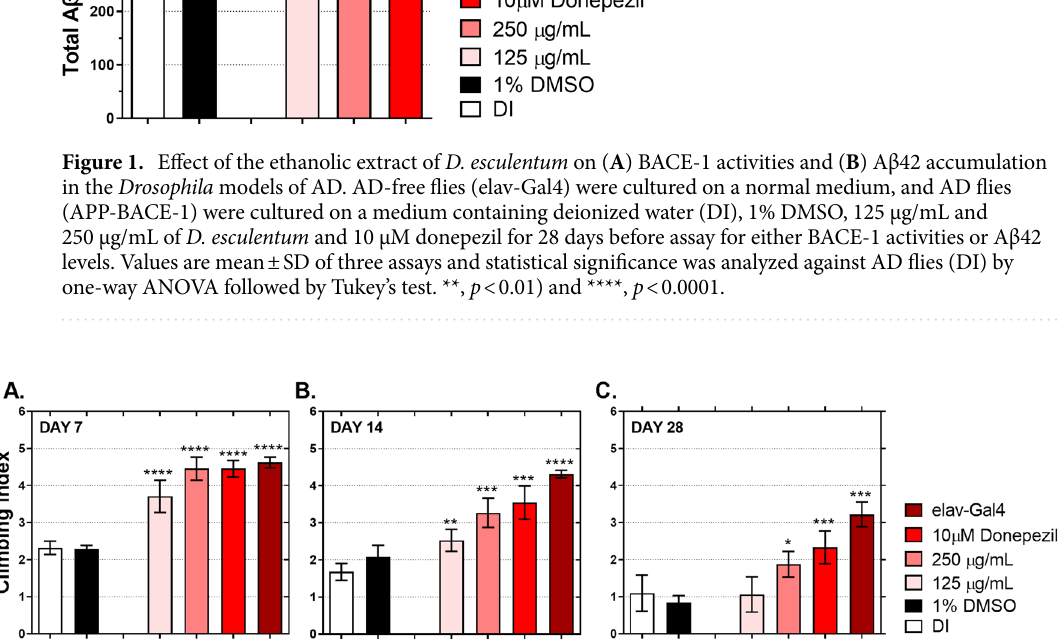
Figure 2. Effects of the ethanolic extract of D. esculentum on Drosophila climbing ability. AD-free flies (elav- Gal4) cultured on a normal medium, and AD flies (APP-BACE-1) cultured on a medium containing deionized water (DI), 1% DMSO, 125 µg/mL and 250 µg/mL of D. esculentum and 10 µM donepezil for the indicated days were assessed for climbing ability. Values are mean ± SD of three assays and statistical significance was analyzed against AD flies (DI) by one-way ANOVA followed by Tukey’s test. *, p < 0.05; **, p < 0.01; ***, p < 0.001 and ****, p <